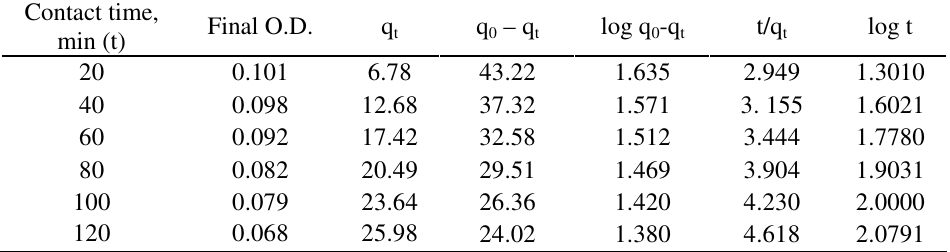
Table 8. Kinetic data (Initial dye concentration (q concentration = 0.384; equilibration dye concentration (q Contact time,